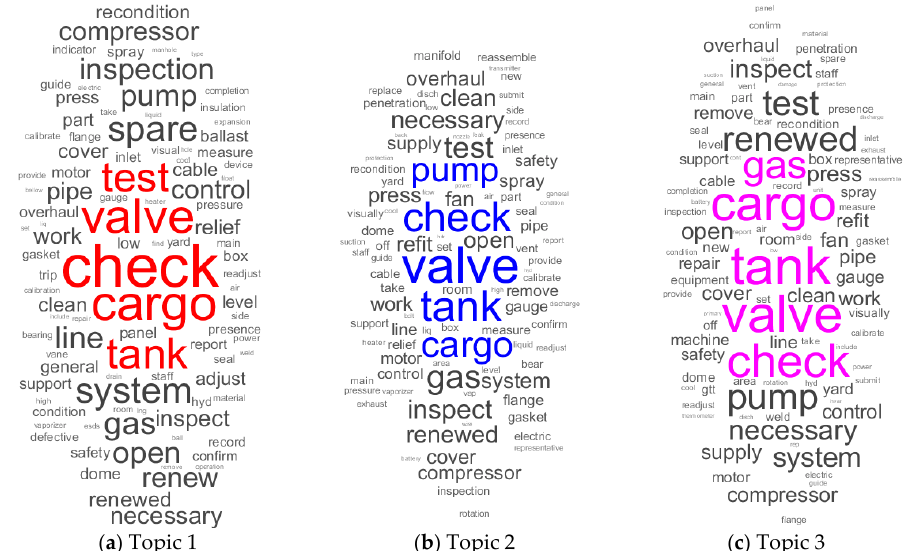
Figure 5. Word clouds using single-word frequencies of preprocessing dock specification texture data from the collected documents. Maintenance item word cloud of ( a ) vessels aged less than 10 years, ( b ) vessels aged between 10 and 20 years, and ( c ) vessels aged more than 20